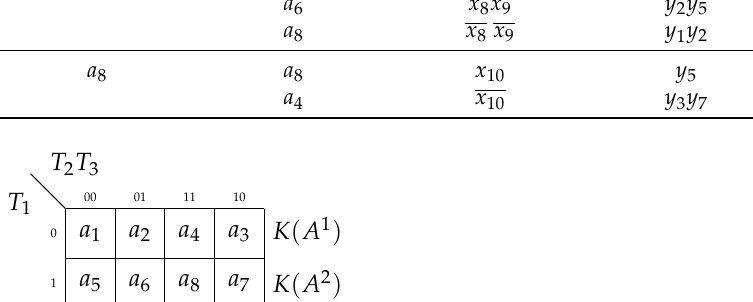
Figure 6. Complex state codes of Mealy FSM MP C Y ( S 0 )